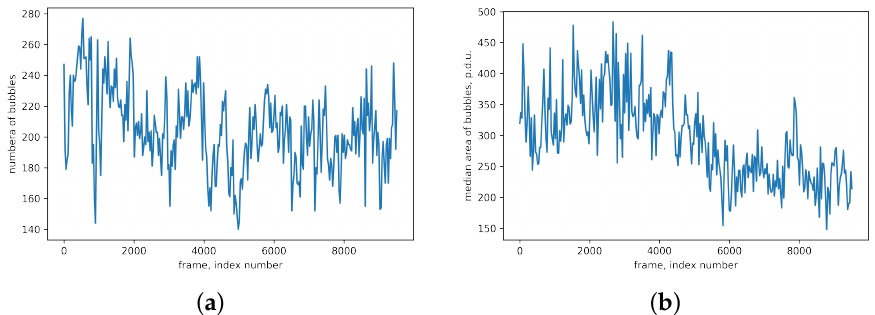
Figure 14. Dynamics of changes in observed bubble quantity and their median area in the frame: ( a ) variability in the number of registered bubbles and ( b ) variation of the median bubble area in the view field (frame indexes are indicated on the x-axis). Both the number and median area might be considered as a Gaussian process as expected for a scale of one second.